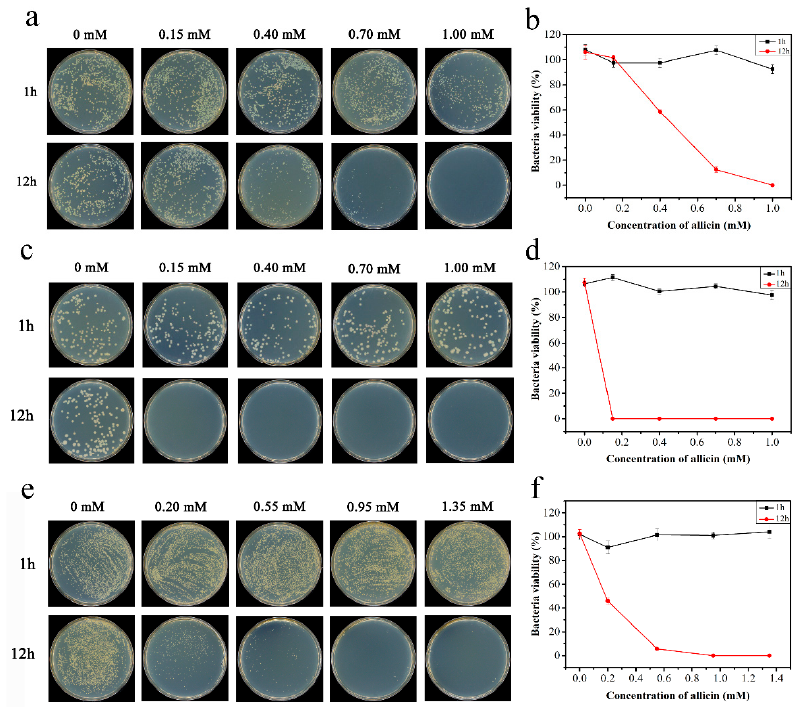
Figure 4. Photographs of bacterial colonies of E. coli ( a ), B. subtilis ( c ) and S. aureus ( e ) treated by the antibacterial patches with different concentrations of allicin. ( b ), ( d ) and ( f ) show the corresponding colony number in ( a ), ( c ) and ( e ), respectively.